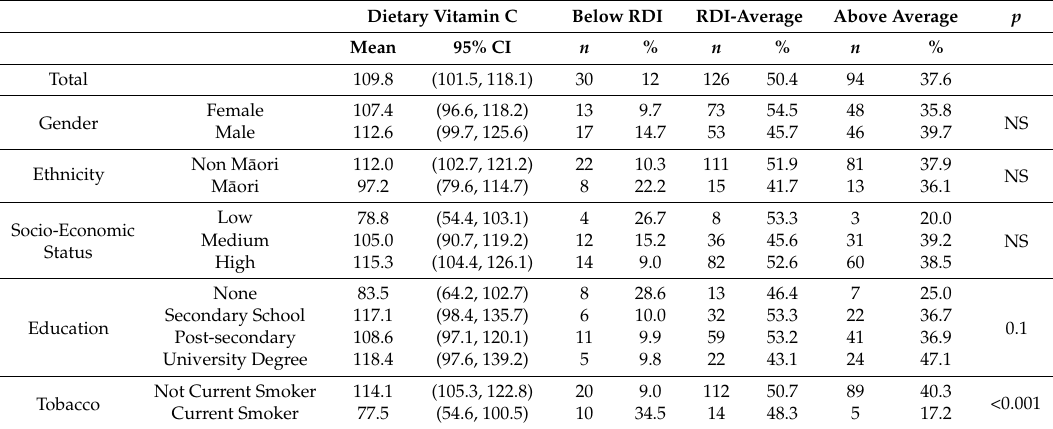
Table 5. Categories of dietary vitamin C